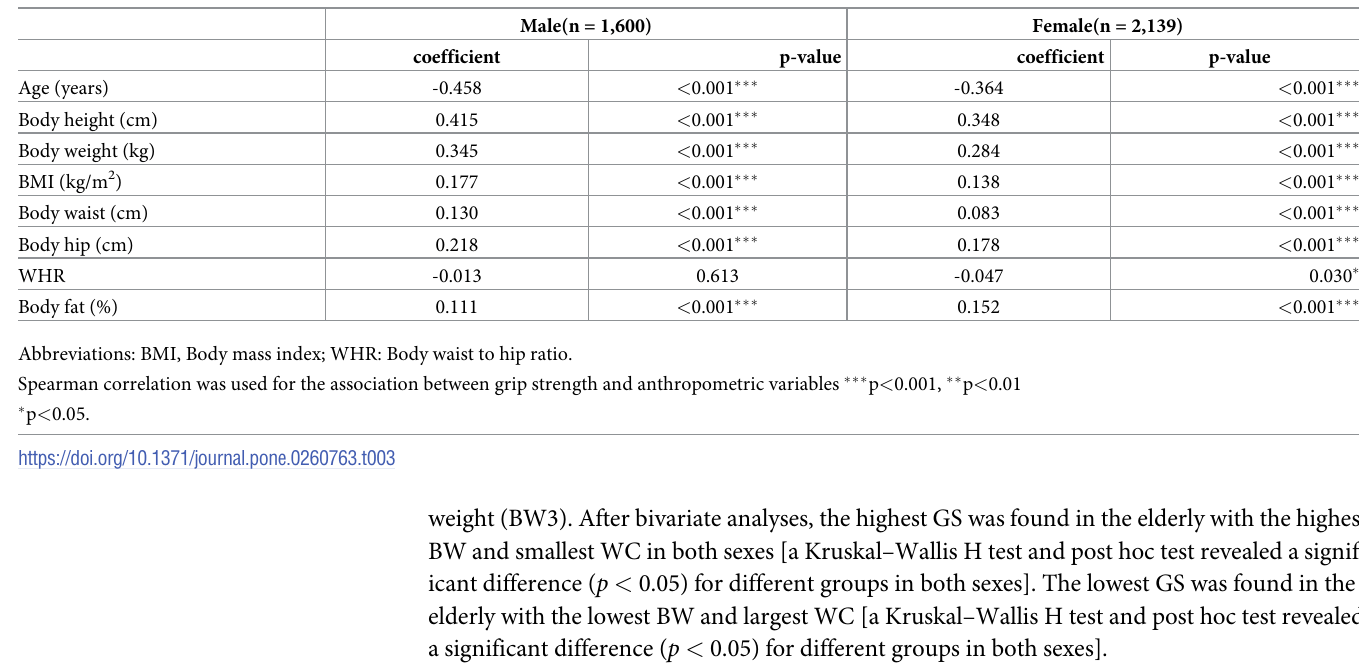
Table 3. Spearman correlation between grip strength and anthropometric variables among elderly population with gender specifications.